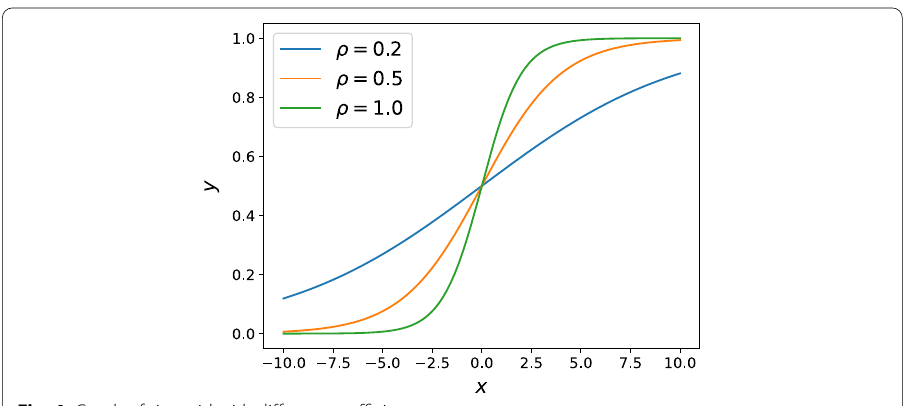
Fig. 4 Graph of sigmoid with different